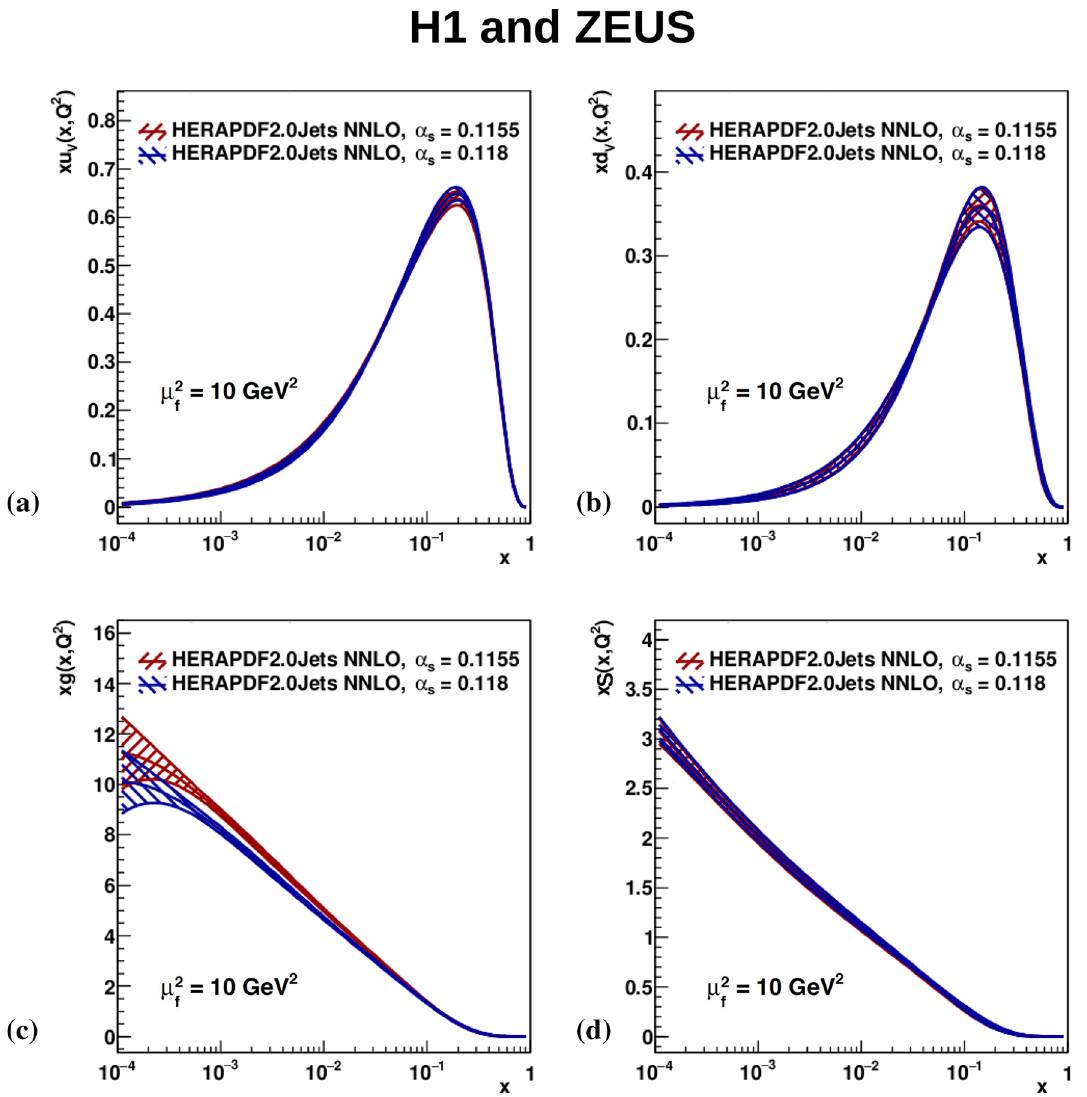
Fig. 5 Comparison of the parton distribution functions a xu v , b xd v , c xg and d xS = x ( ¯ U + ¯ D ) of HERAPDF2.0Jets NNLO with fixed α ( M 2 ) = 0 . 1155 and α ( M 2 ) = 0 . 118, at the scale μ 2 s s Z Z